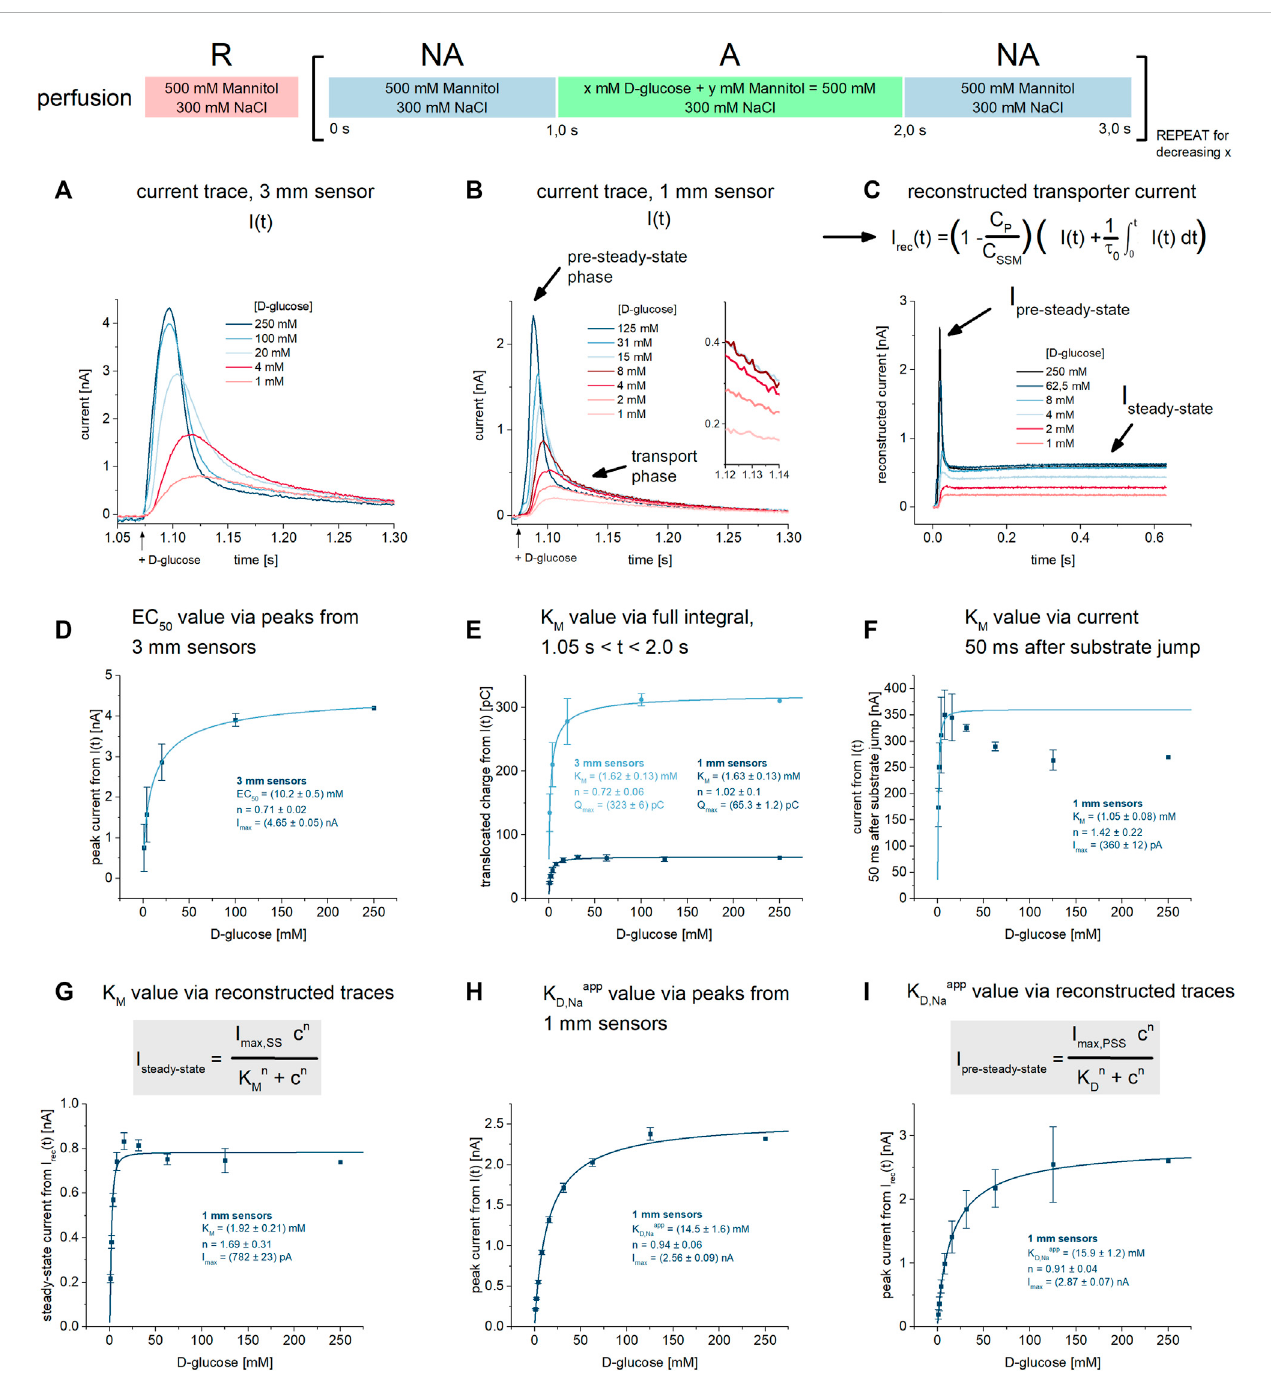
FIGURE 1 K M and K D,Na app values for D-glucose under Na + /D-glucose cotransport conditions. All current traces were recorded on 3 mm or 1 mm sensors as indicated, equilibrated at pH 7.4 in the presence of 300 mM Na + in all measurement solutions and upon D-glucose concentration jumps between 1 mM and 250 mM. Averaged data of n = 3 different sensors is shown. (A) Representative current traces recorded on one 3 mm sensor. The large sensor surface andhighsignal-to-noisecomesatthecostoftimeresolution:peakcurrentsarede fi nedbybothPSSandtransportcomponents. (B) Representativecurrenttraces recorded on one 1 mm sensor. Compared to 3 mm sensors, time resolution is higher and a fast decaying PSS phase can be distinguished from the slow decaying transport phase. The inset shows the current at t = 1.13 s used for the analysis in (F). (C) Via circuit analysis, transporter currents were reconstructed from the current traces shown in (B) (Tadini-Buoninsegni and Fendler, 2015). Steady-state currents are revealed from the transport phase of the original current. I pre-steady-state and I steady-state isusedfortheanalysisofK M andK D valuesin(G)and(I),respectively. (D) Peakcurrentsfrom3 mmsensorsare fi ttedusingahyperbolicequationtoderivean EC 50 of 10.2 ± 0.5 mM for D-glucose. It represents a value which is between K M and K D,Na app , since the peak is affected by both D-glucose induced PSS and transport phases. (E) Integrals from 3 mm to 1 mm sensors are fi tted using a hyperbolic equation to derive K M values of 1.62 ± 0.13 mM and 1.63 ± 0.13 mM for D-glucose, respectively. Integrals re fl ect theoverall charge translocationwhich isdominatedby transport; PSS chargetranslocationissmall incomparison and may beneglected, hence the resulting EC 50 re fl ects the real K M . (F) Currents 50 ms after the sugar concentration jump are fi tted using a hyperbolic equation to derive a K M of 1.05 ± 0.08 mM for D-glucose. At this time point, PSS currents are already zero, allowing for the read-out of the transport phase directly. The resulting EC 50 re fl ects a K M .